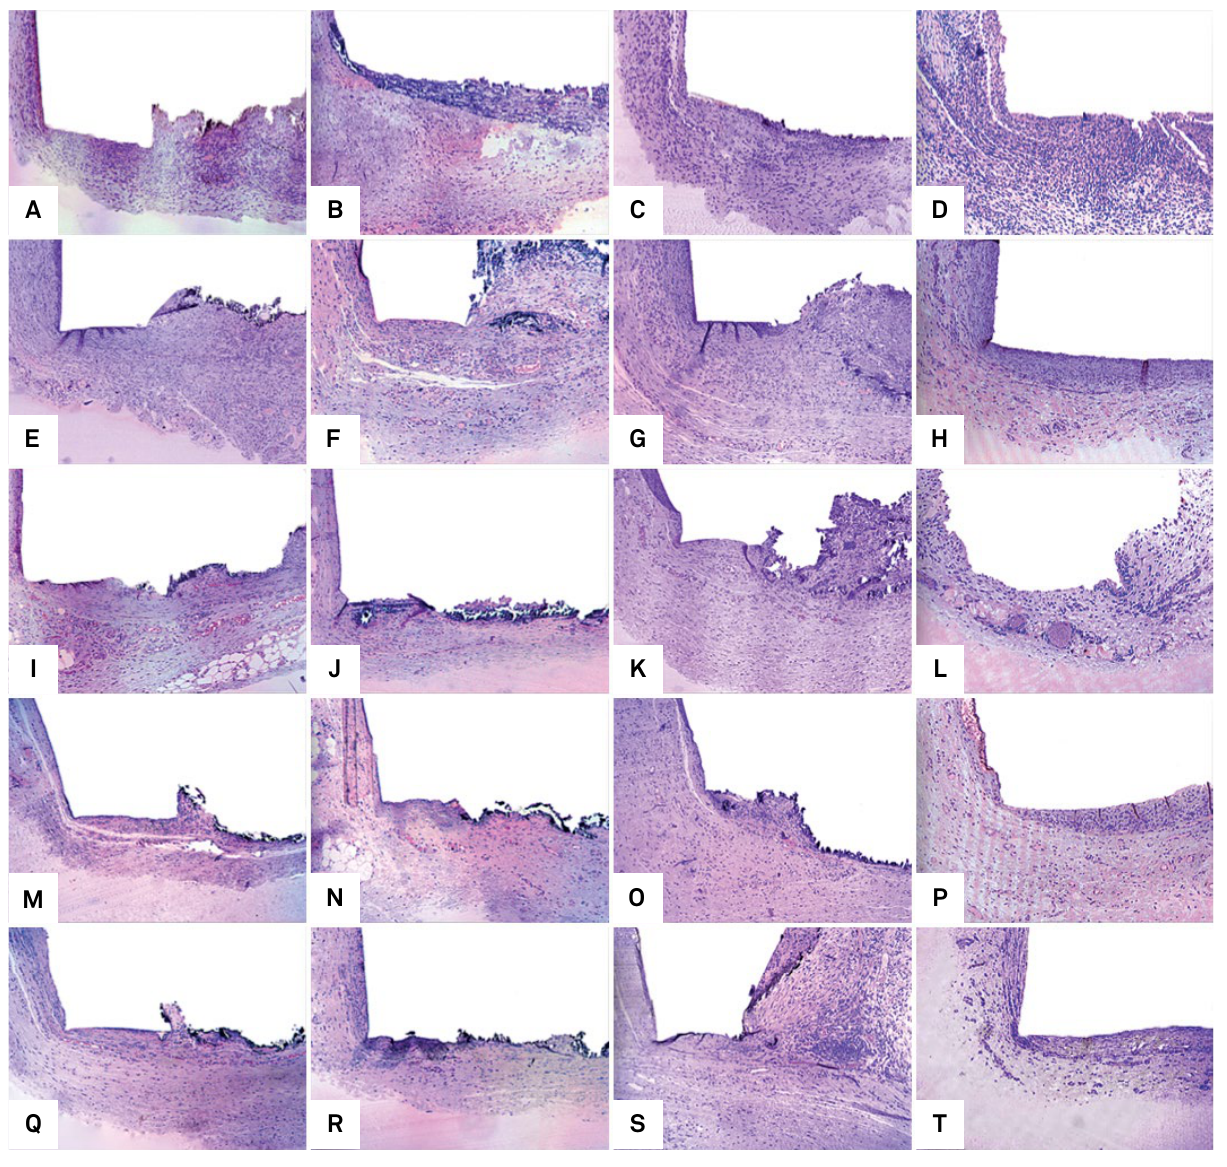
Figure 2. Histological analysis of experimental groups on postoperative days 7, 15, 30, 60 and 90 (HE,